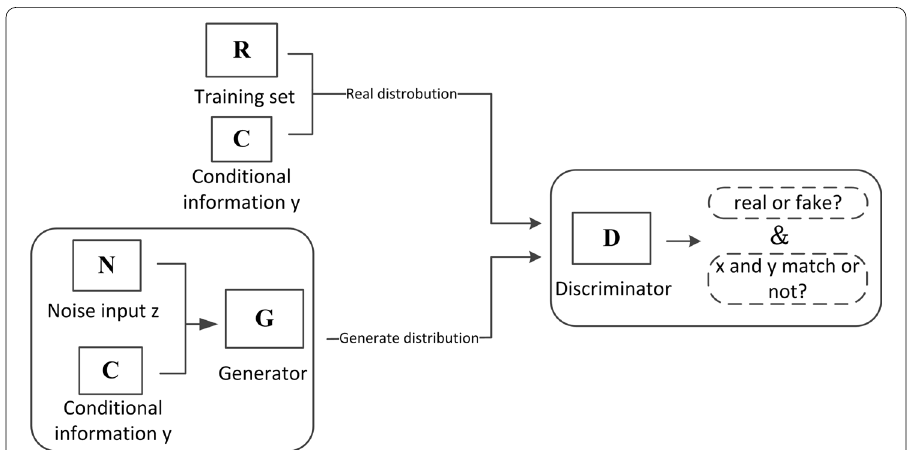
Fig. 2 Schematic diagram of classical conditional generative adversarial